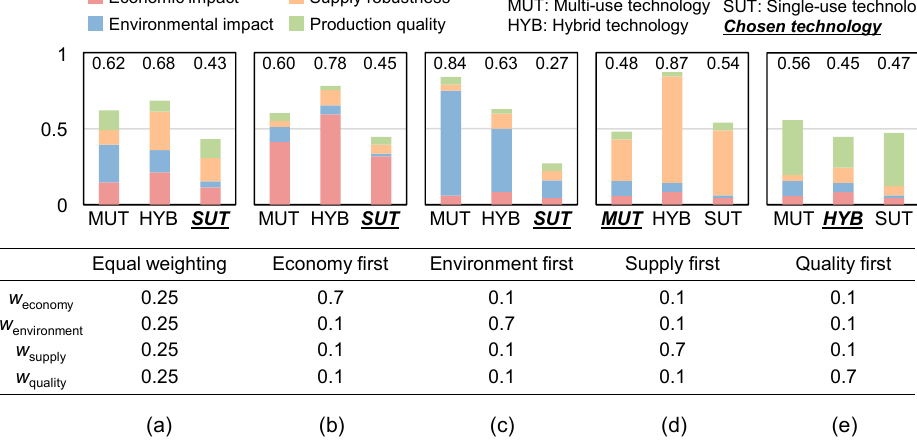
Figure 6. Landscape results of the total score for different production scenarios of ( A ) large-scale in campaign production mode with minimal change-over, ( B ) large scale in alternating production mode with maximal change-over, ( C ) small-scale in campaign production mode with minimal change-over, and ( D ) small-scale in alternating production mode with maximal change-over.